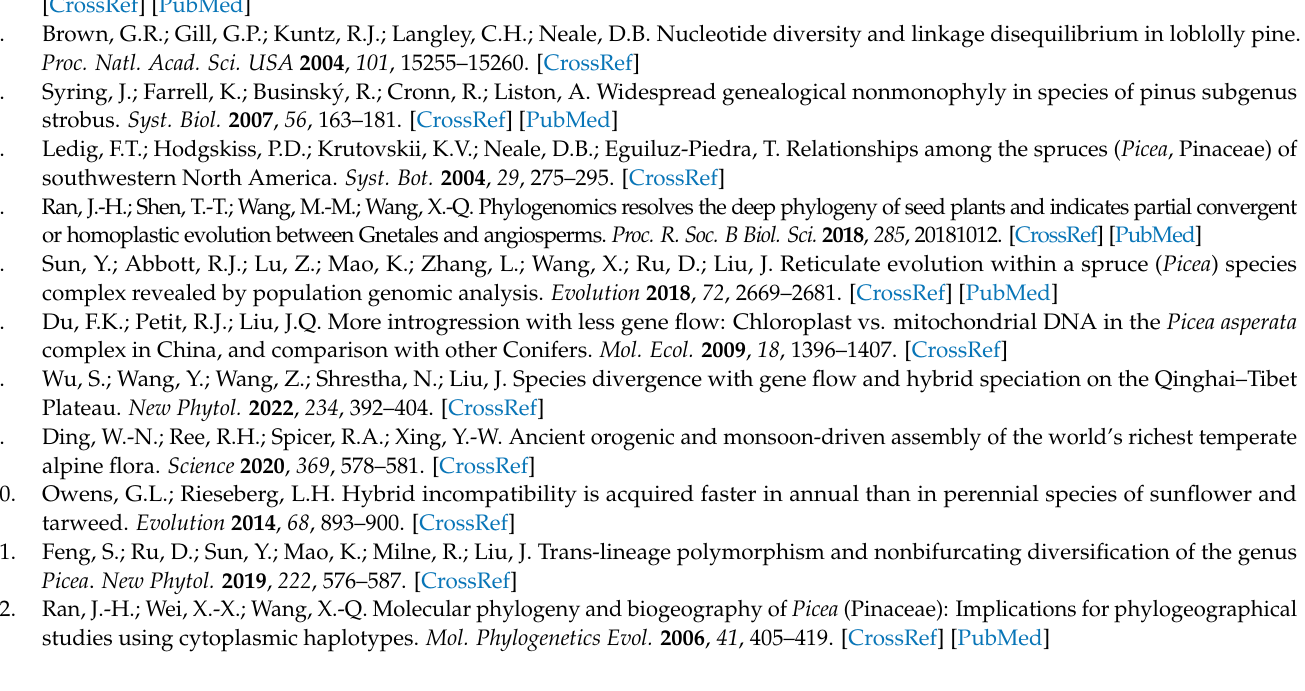
Table S3: GO categories of selected genes in P. koraiensis MKS (Mengkeshan) population; Table S4: GO categories of selected genes in P. koraiensis WYL (Wuyiling)